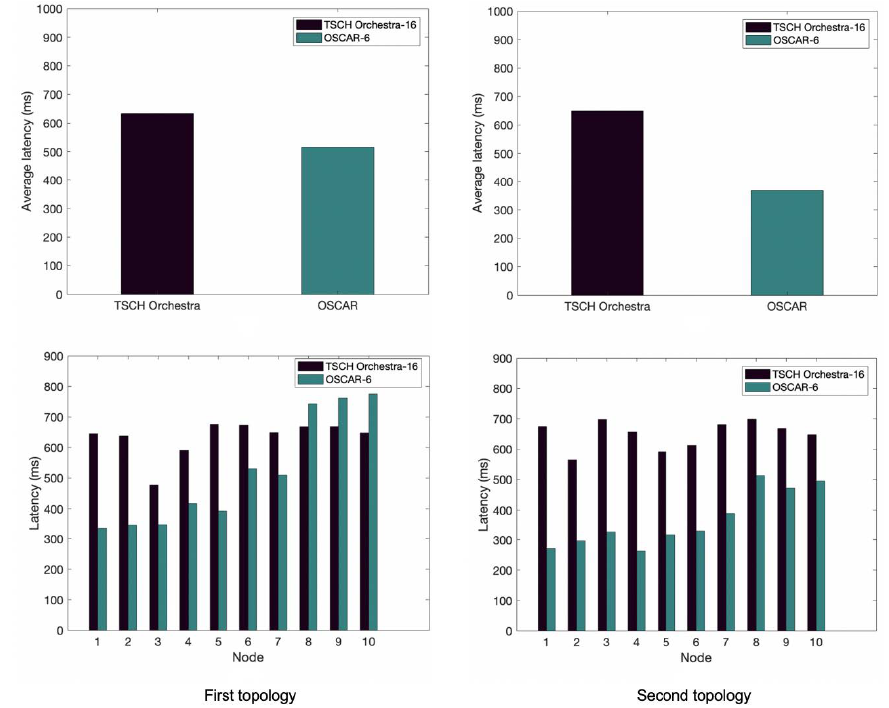
Figure 6. Average end-to-end delay of OSCAR and Orchestra for the first and second